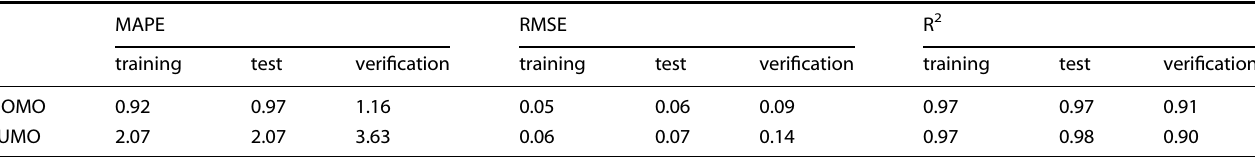
Table 1. Summary of MAPE (%), RMSE (eV) and R 2 for the training, test and veri fi cation datasets using the revised features. MAPE